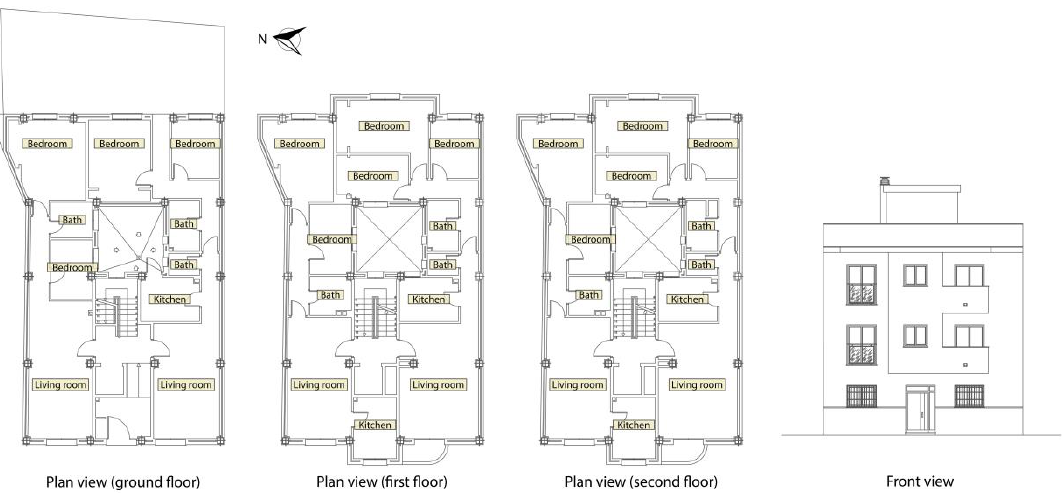
Figure 2. Graphical representation of floors and elevations of the building analysed.